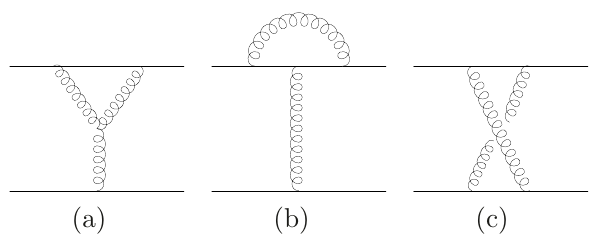
Figure 4 . Some “multi-gluon-exchange” diagrams contributing to